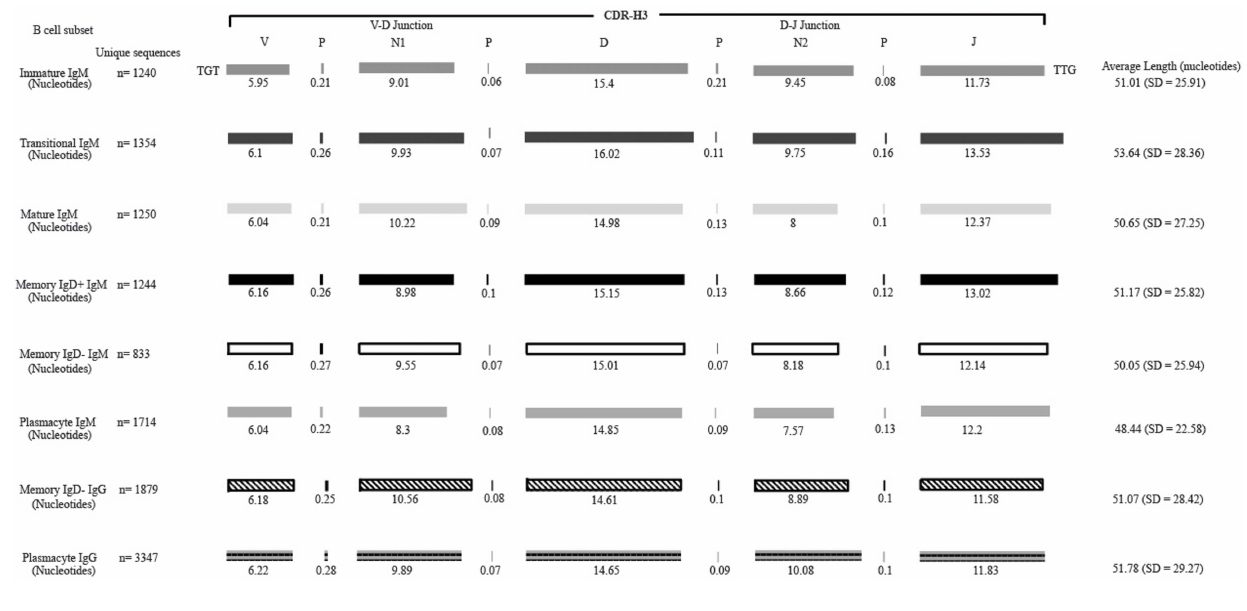
calculated with the components of the CDR-H3, namely theV length, P-nucleotides 3 (cid:48) of theV, N1 nucleotides, P-nucleotides 5 (cid:48) of D, D